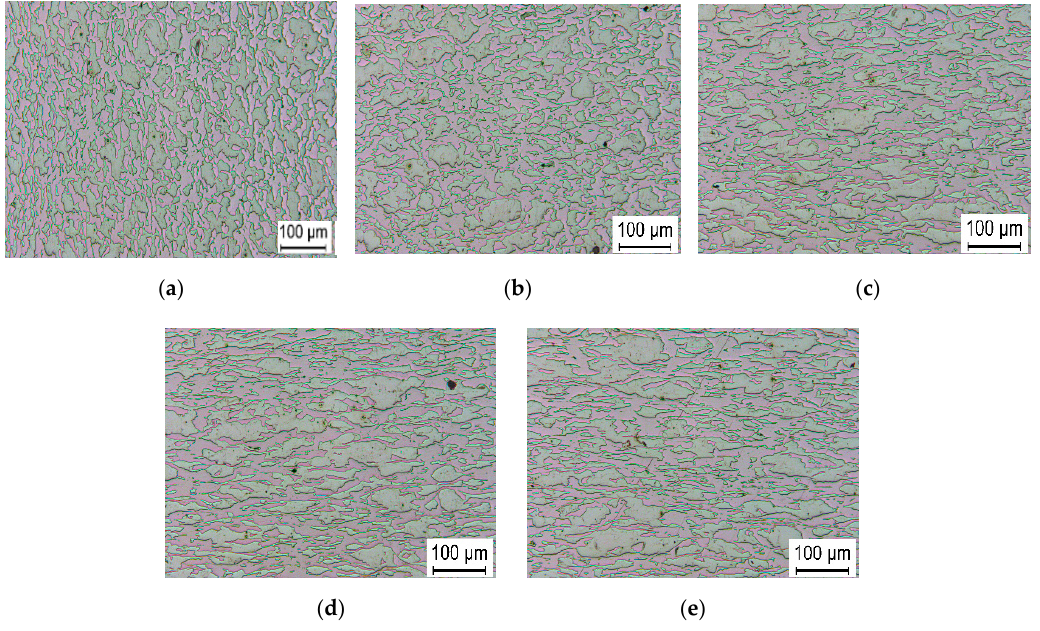
Figure 3. The microstructure and position of micro hardness tests. ( a ) Z1:1 mm; ( b ) Z2:3.15 mm; ( c ) Z3:5.3 mm; ( d ) Z4:7.45 mm; ( e ) Z5:9.6 mm below the surface.